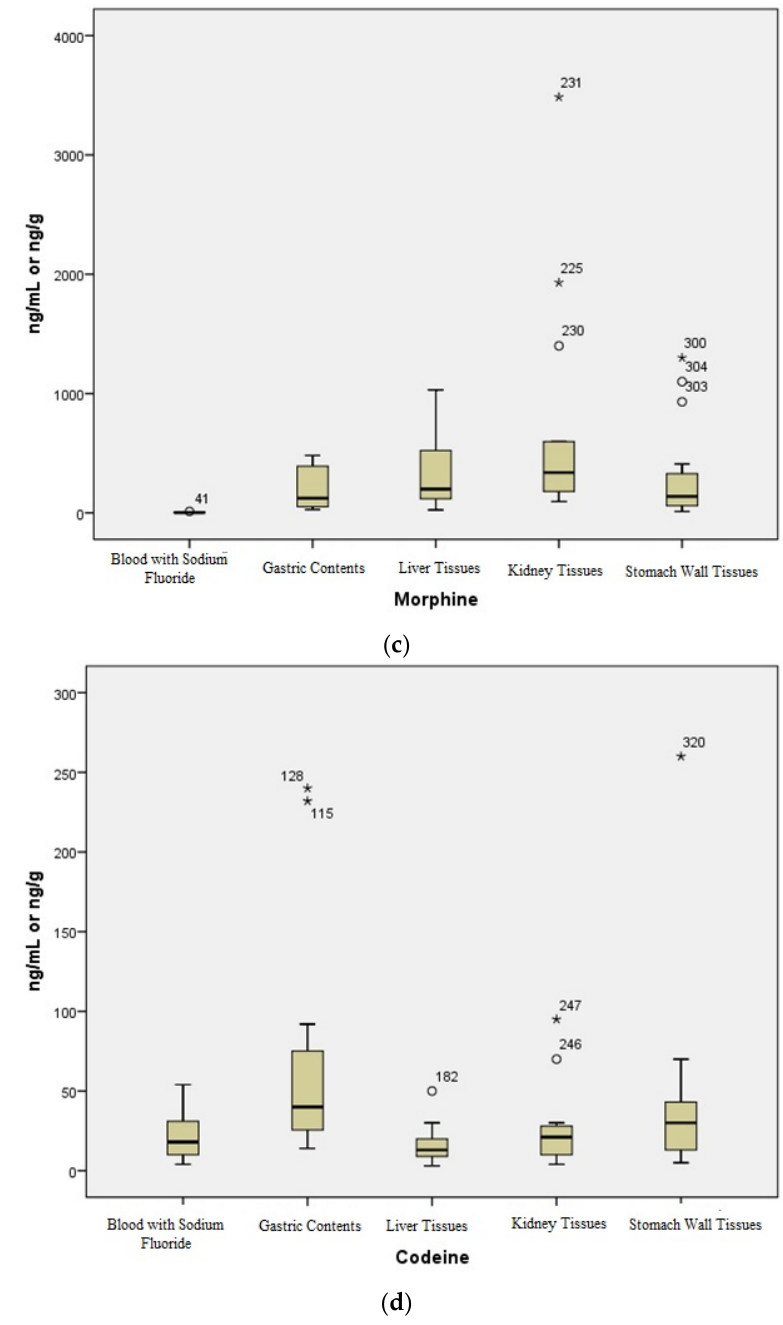
Figure 2. Concentration ratios of ( a ) 6-acetylmorphine (6-MAM), ( b ) 6-acetylcodeine (6-AC; no 6-AC was detected in liver and kidney tissues), ( c ) morphine, and ( d ) codeine in the blood with sodium fluoride (ng/mL), gastric contents (ng/mL), liver tissues (ng/g), kidney tissues (ng/g,) and stomach wall tissues (ng/g) of 16 heroin-related death cases included in the current study. The horizontal boxes represent the median concentration ratio, and the box lengths represent the 25–75th percentile. The whiskers represent the smallest and largest value within 1.5 times the interquartile range, and circles (outlier) represent values exceeding at least 1.5 times the interquartile range and extremes (asterisks) represent values exceeding at least 3.0 times the interquartile range .